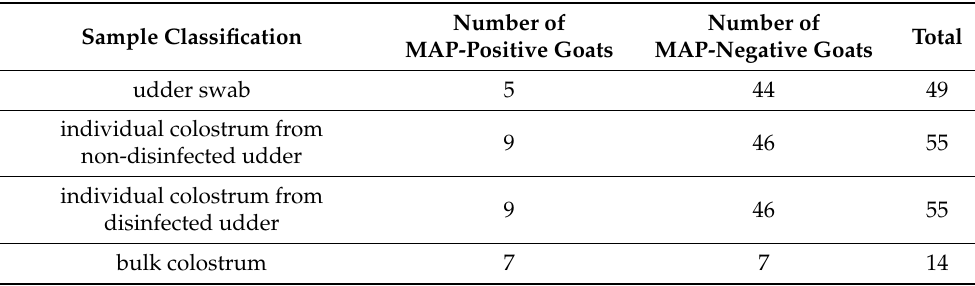
Table 1. Type and number of samples from Mycobacterium avium subspecies paratuberculosis (MAP)- positive and negative goats within the study. A bulk colostrum sample was defined as originating from MAP-positive goats if at least one of the contributing goats was classified as MAP-positive. Number of Number of Total Sample Classification MAP-Positive Goats MAP-Negative Goats udder swab 5 44 49 individual colostrum from 9 46 55 non-disinfected udder individual colostrum from 9 46 55 disinfected udder bulk colostrum 7 7